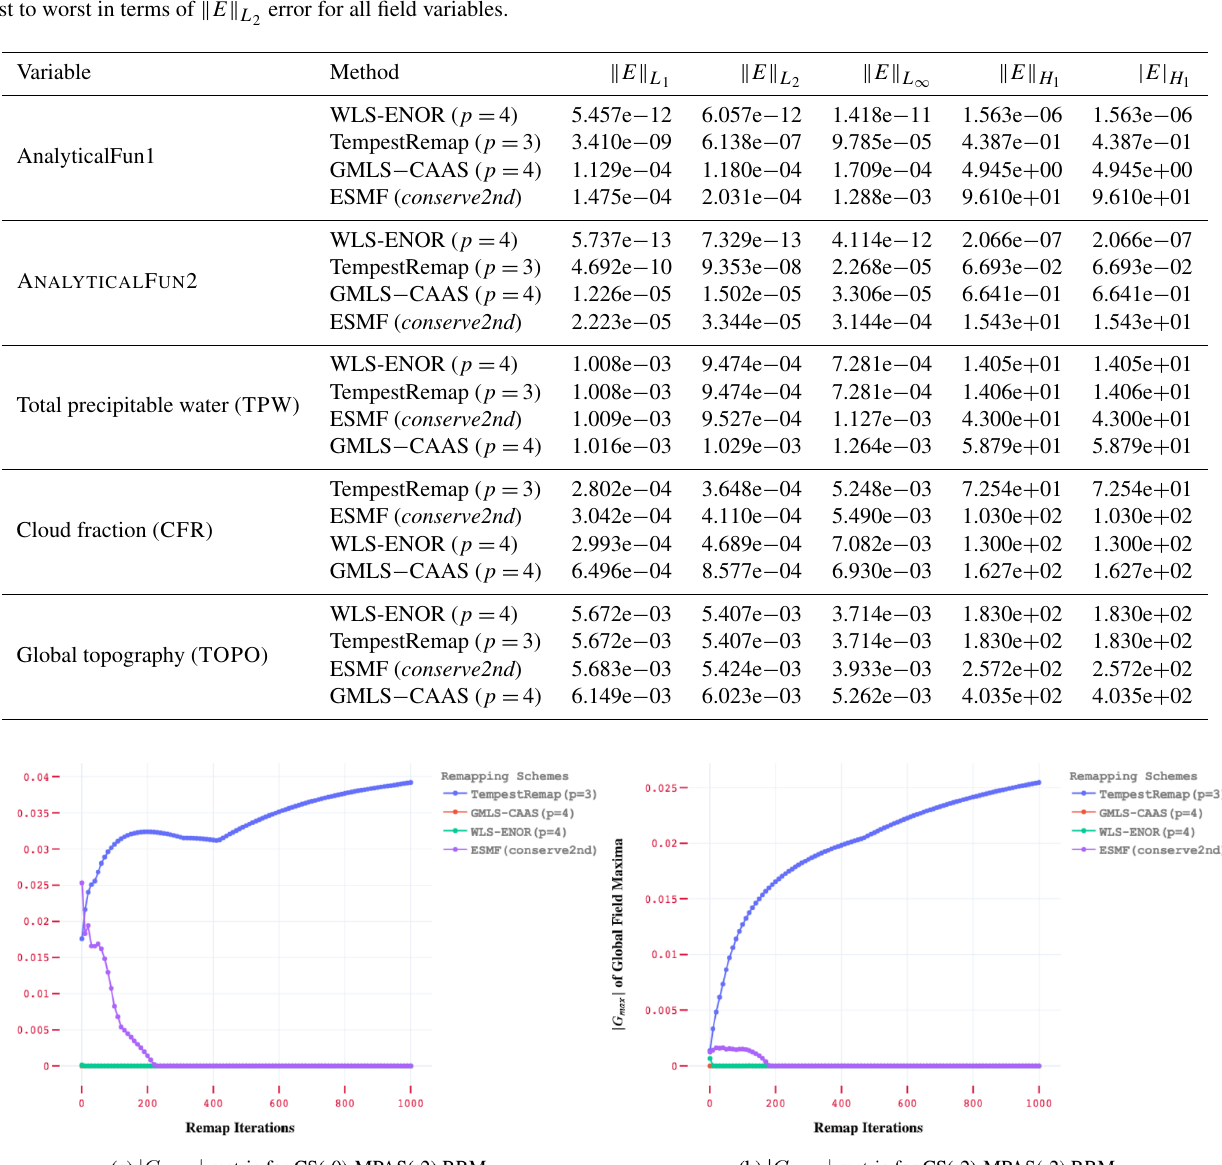
Figure 13. | G max | metric for the CFR field on CS-MPAS RRM with (a) coarse to fine and (b) fine to fine